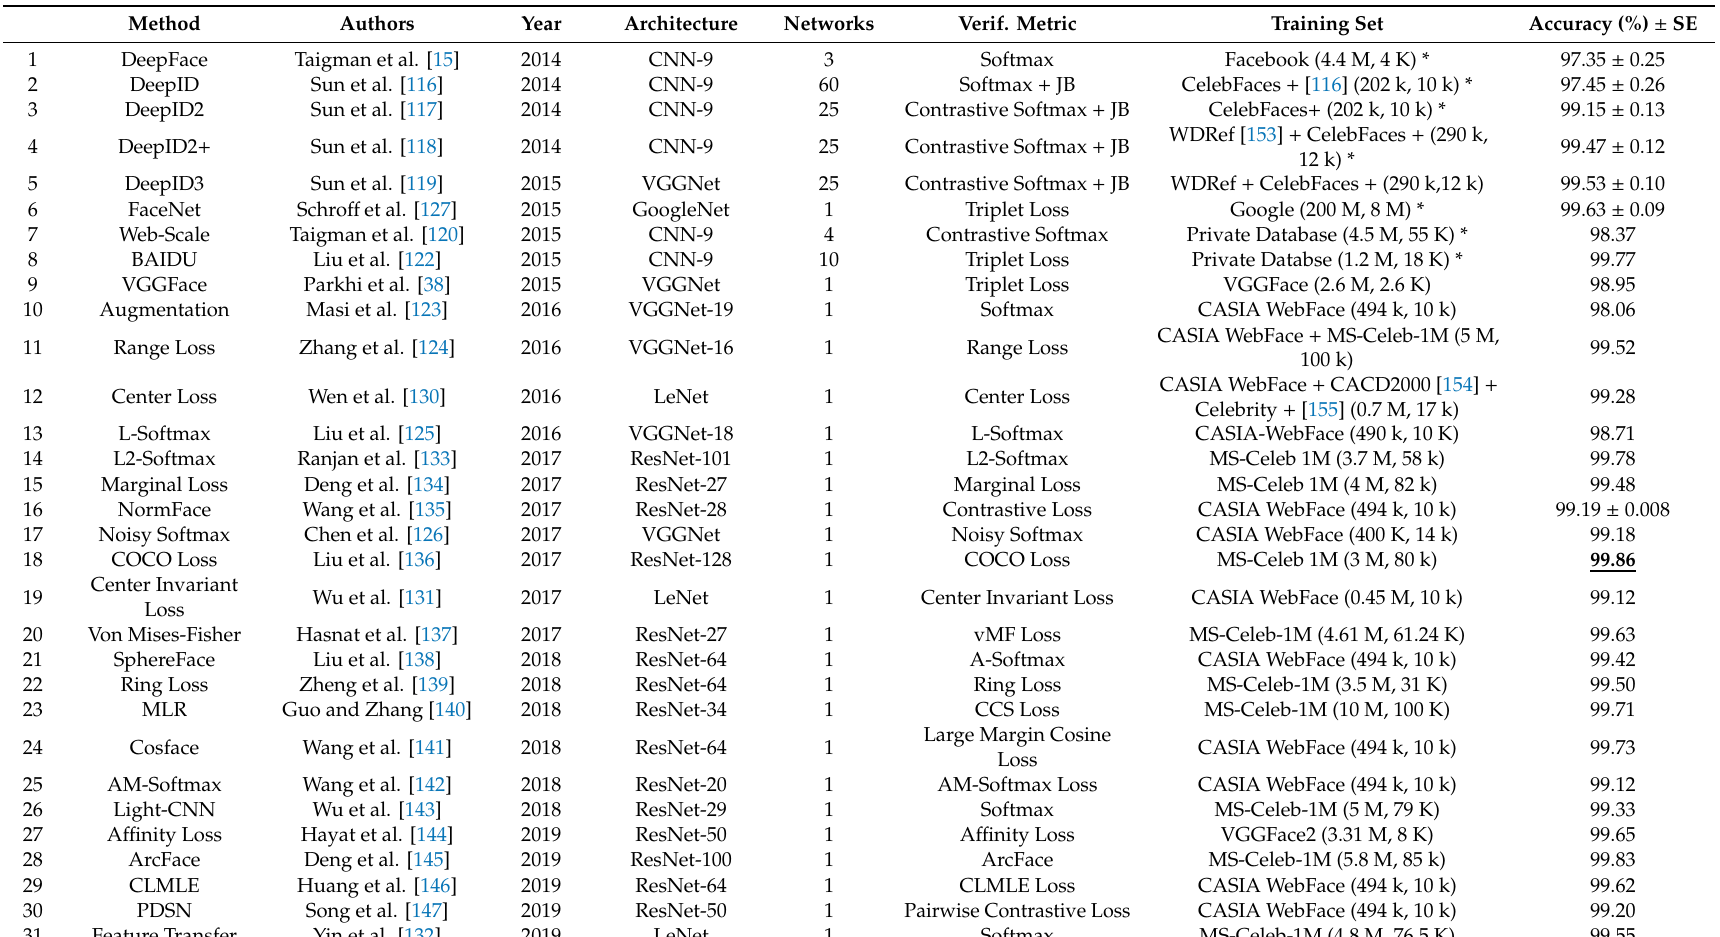
Table 3. Comparative summary of di ff erent deep face verification approaches on the Labeled Face in the Wild (LFW)